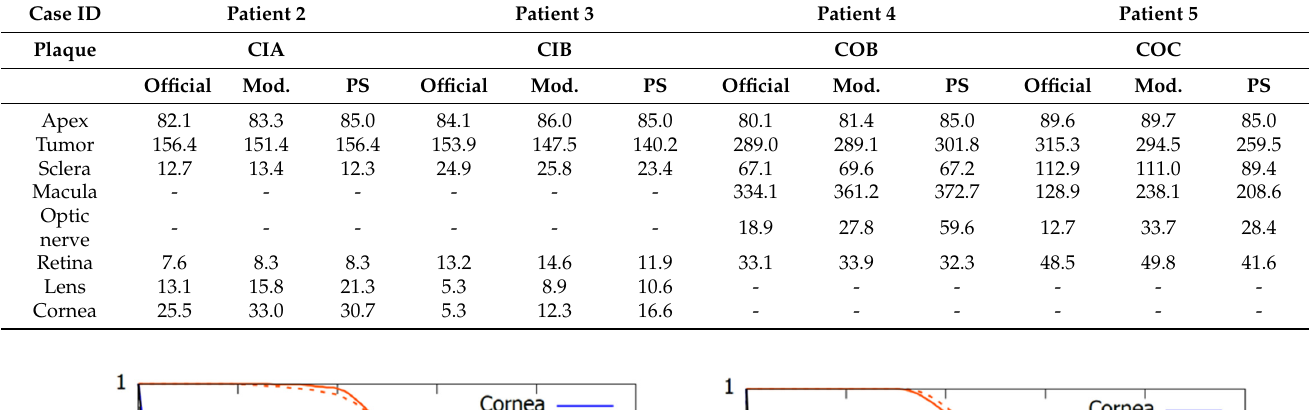
Table 6. Dose at apex and mean doses to the tumor and critical structures, in Grays, for the real clinical cases from Miras et al. [16], calculated with the Plaque Simulator (PS) and with EyeMC using the official and modified (Mod.) plaque geometries.